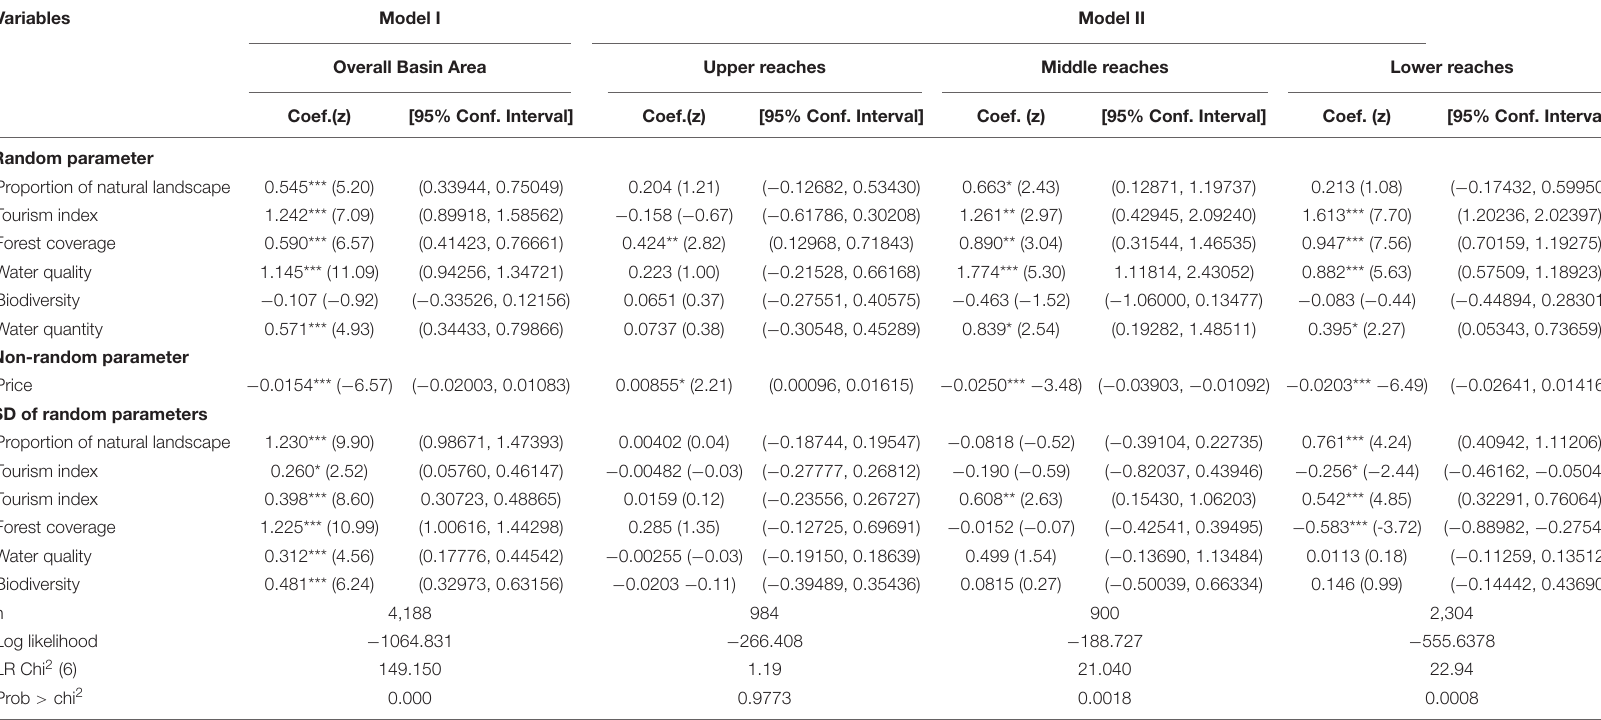
TABLE 5 | Results of RPL modeling of CE